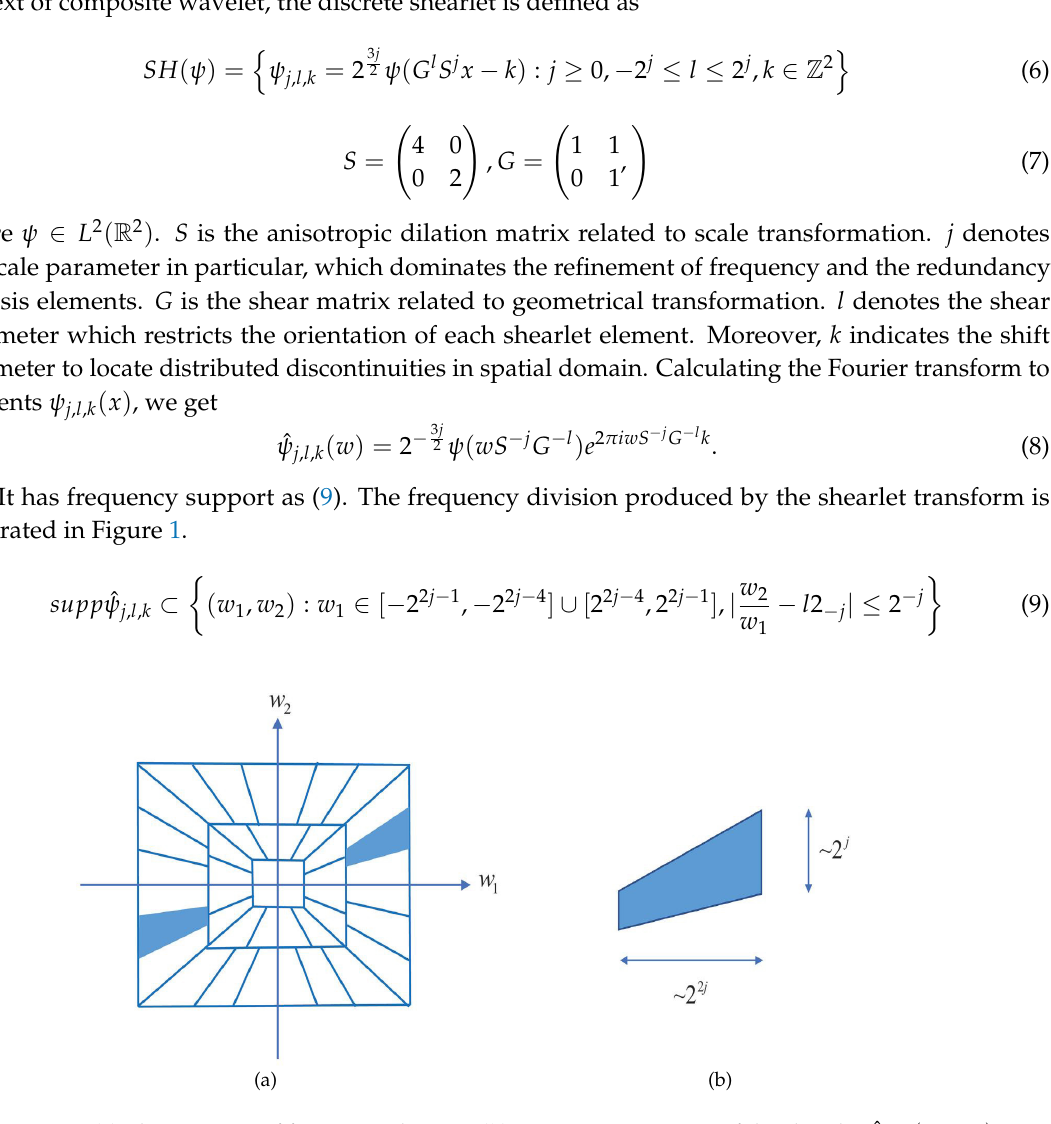
Figure 1. ( a ) The partition of frequency domain; ( b ) Frequency structure of the shearlet ˆ ψ j , l , k ( w 1 , w 2 ) , for w 1 > 0, w 2 >